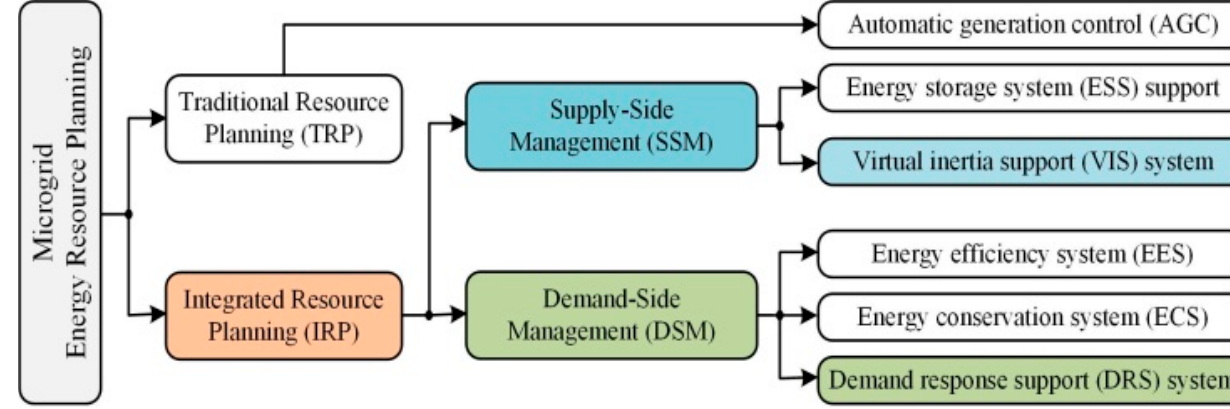
Figure 1. Energy resource planning in microgrids.